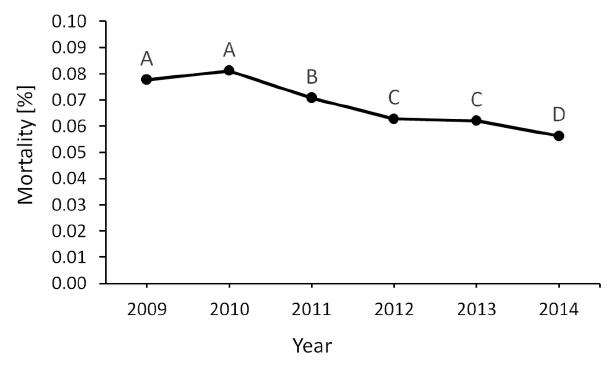
Figure 4. Trends in the transport-related mortality in finisher pigs in the period from 2009 to 2014. A-D Mortality in columns with different superscripts differ significantly